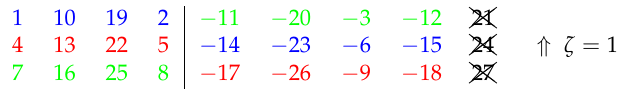
Table 7. WDT for a single-layer, three-phase coil winding with N = 27, m = 3 and p = 3. 1